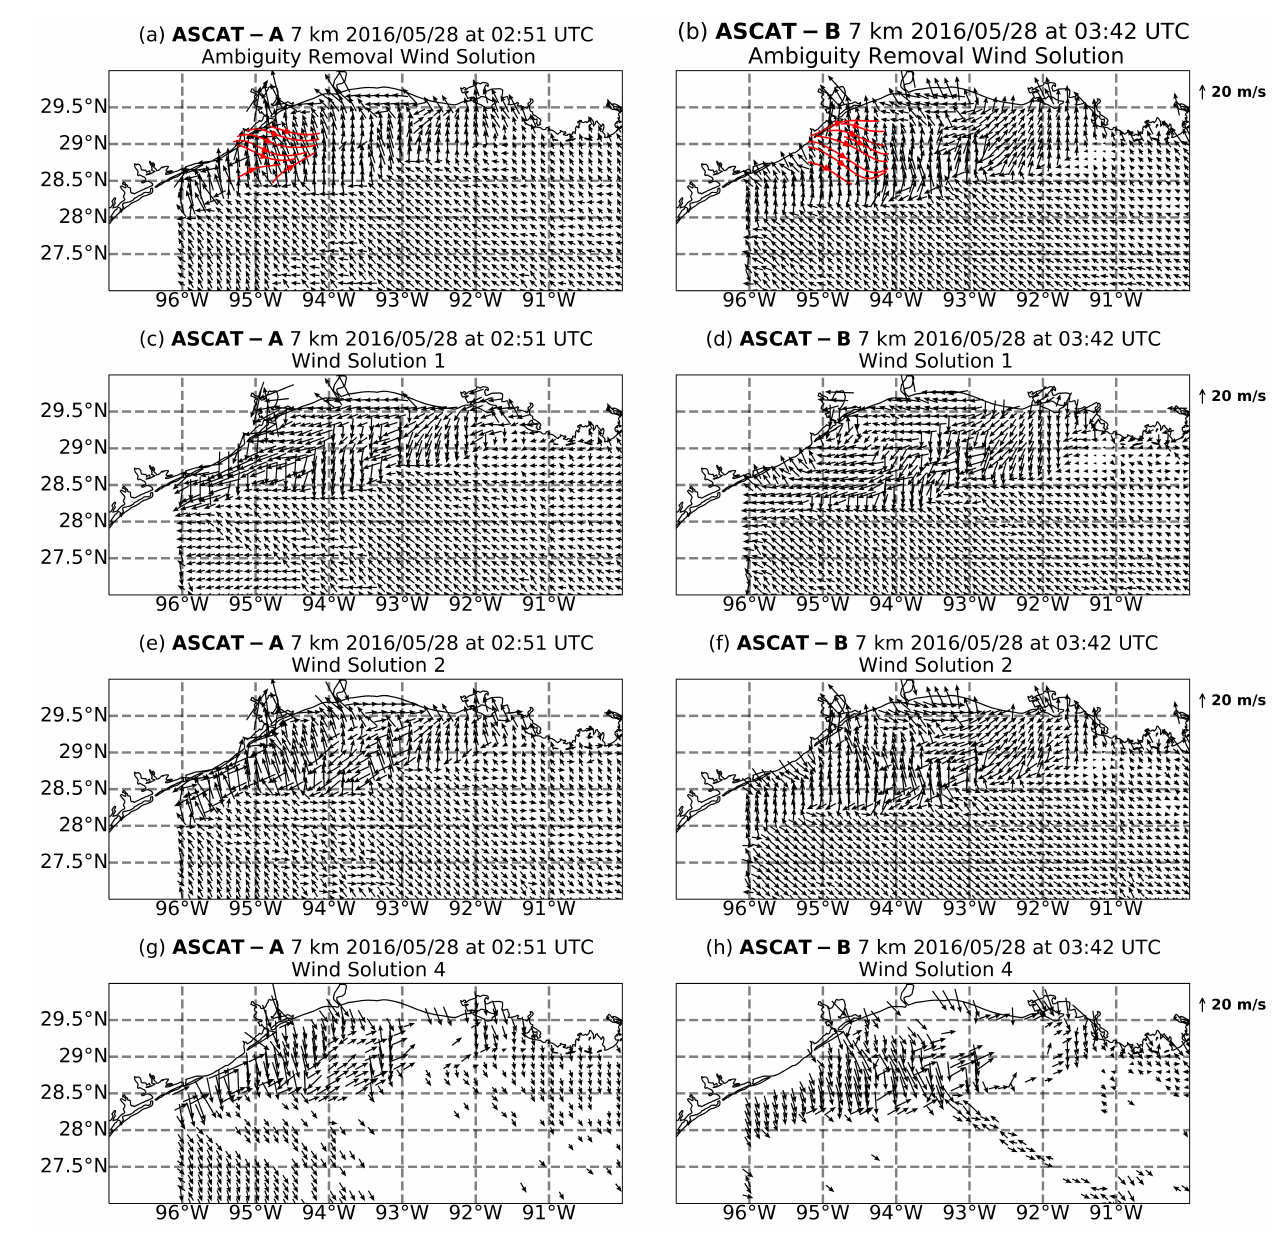
Figure 5. Same configuration as Figure 3, but for the UHR product (7-km spatial resolution) on 28 May 2016 at 02:51 UTC and 03:42 UTC for ASCAT-A and -B, respectively. Wind solution 3 is excluded as rain effects were prevalent and did not provide any valid